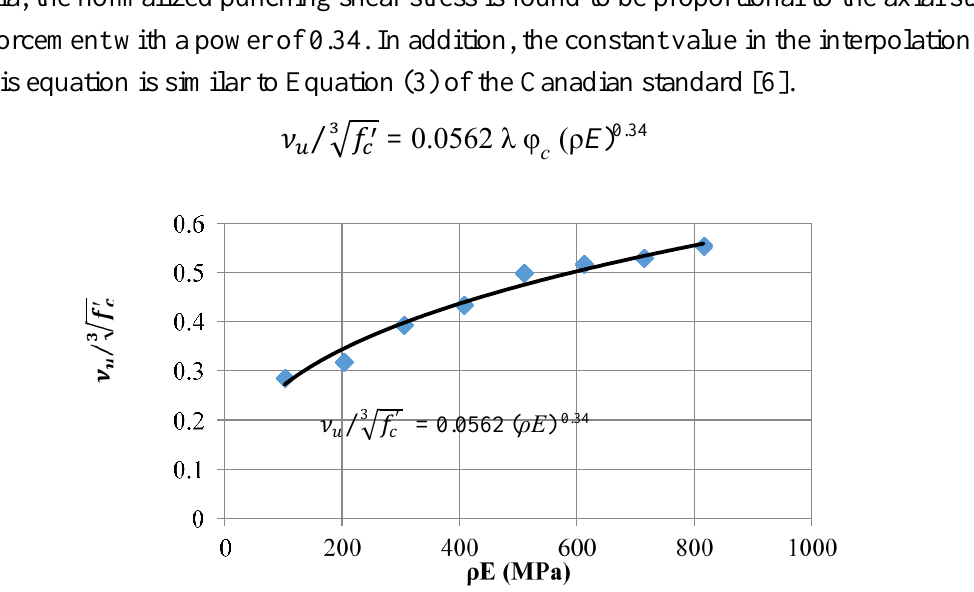
Figure 11. Relationship between the normalized punching shear stress at failure and the axial stiffness of the